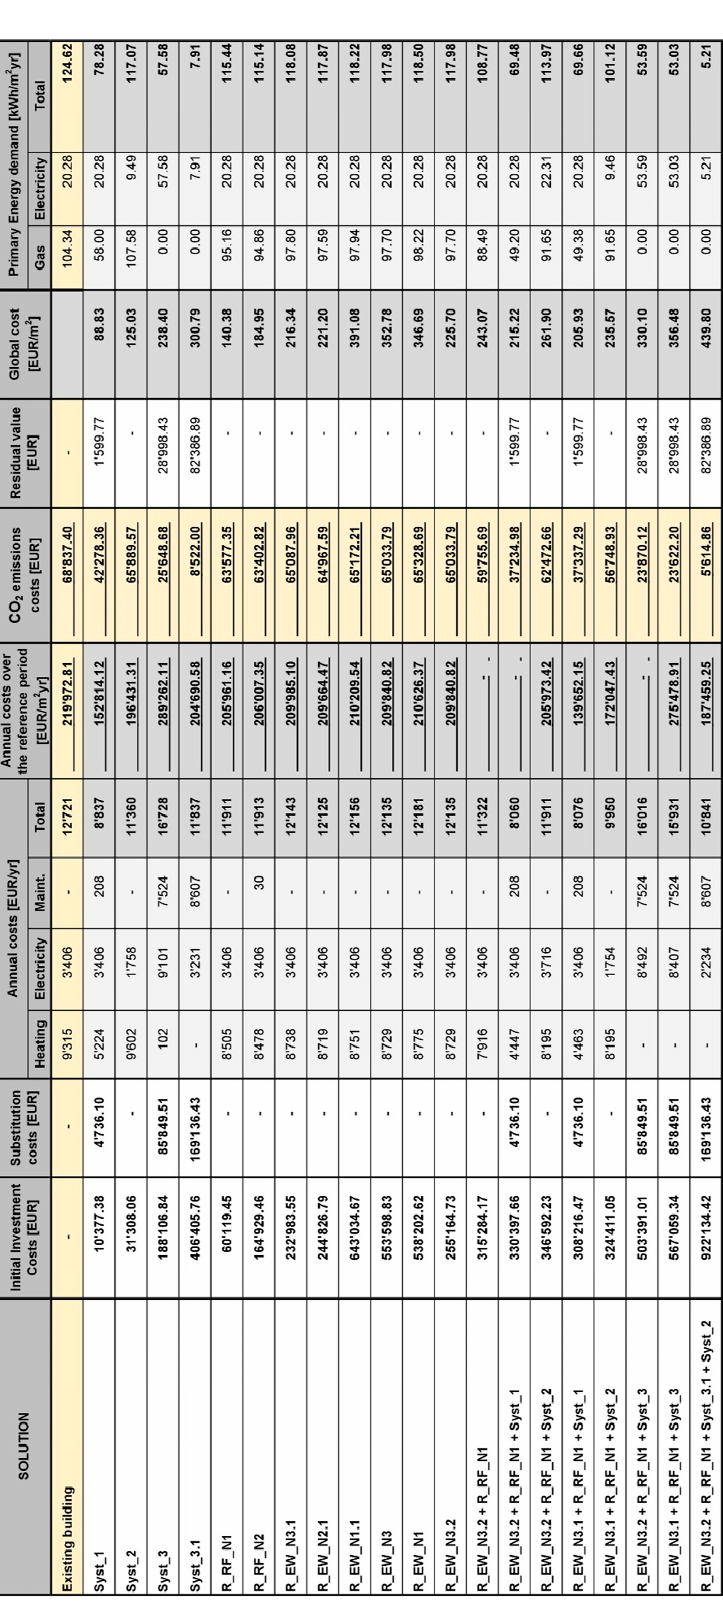
Figure A8. Summary table of cost-optimal methodology for macroeconomic scenario with discount rate equal to 4% for Rodari school.